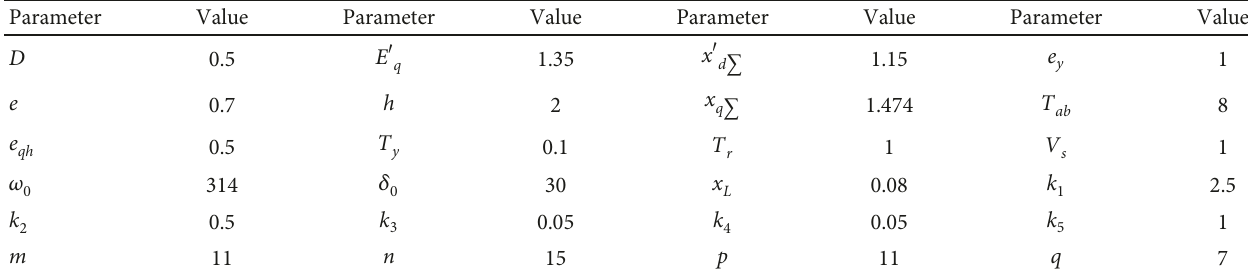
Table 1: The system and controllers